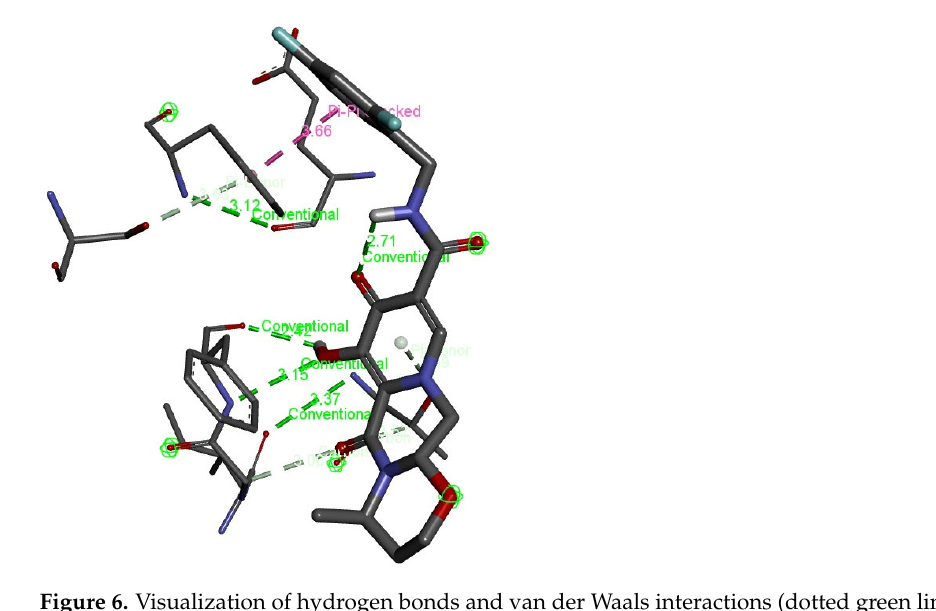
Figure 5. Docked complex of chain engineered dolutegravir (in ball and stick pattern) and MPXVgp169 virulent protein (in cartoon format) by Autodock Vina 1.3.7. Interpretation of Docking Analysis.